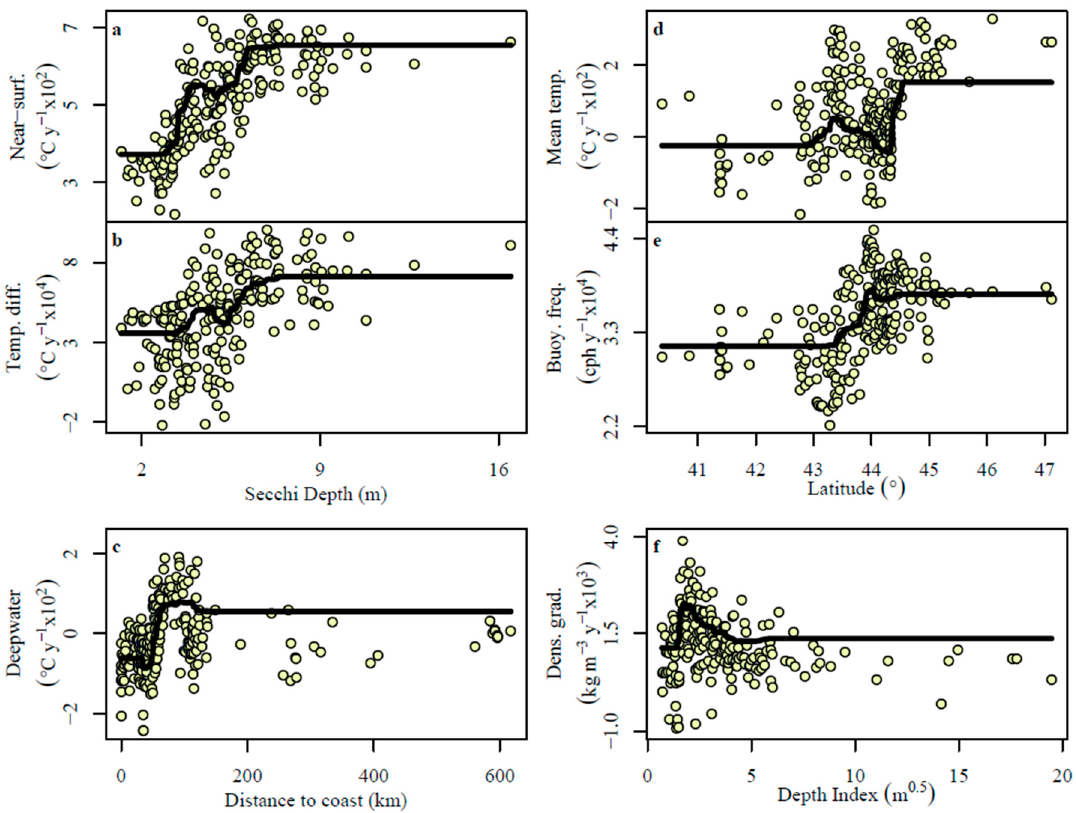
Figure 6. Relationship between boosted regression tree model fits (yellow points) for trends of: ( a ) the near-surface temperature; ( b ) temperature difference between near-surface and deepwater; ( c ) deepwater); ( d ) mean temperature; ( e ) max. buoyancy frequency; and ( f ) density gradient and the explanatory variable with the highest relative influence for each thermal metric for NENA lakes. The lines represent the individual fits for the explanatory variable while holding all other explanatory variables at their median value. Note, the y -axis scales are modified for ease of presentation.